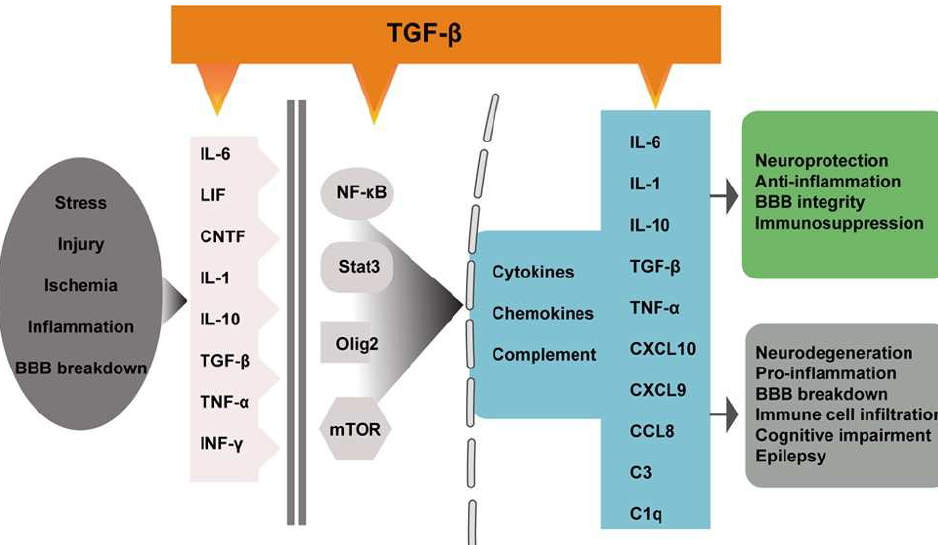
Figure 2. Regulators and signaling pathways of astrocyte reactivity. In response to insults such as stress, injury, ischemia, inflammation, and BBB breakdown, brain cells produce inflammatory factors that trigger astrocyte reactivity through transcriptional pathways involving NF- κ B, Stat3, Olig2, and mTOR. These pathways regulate the production of cytokines, chemokines, and complements, which mediate the neuroprotective or neurodegenerative effects of reactive astrocytes, and are also involved in triggering and maintaining astrocyte reactivity. TGF- β regulates astrocyte reactivity through multiple mechanism: inflammatory factors, transcriptional pathways, and downstream target genes.